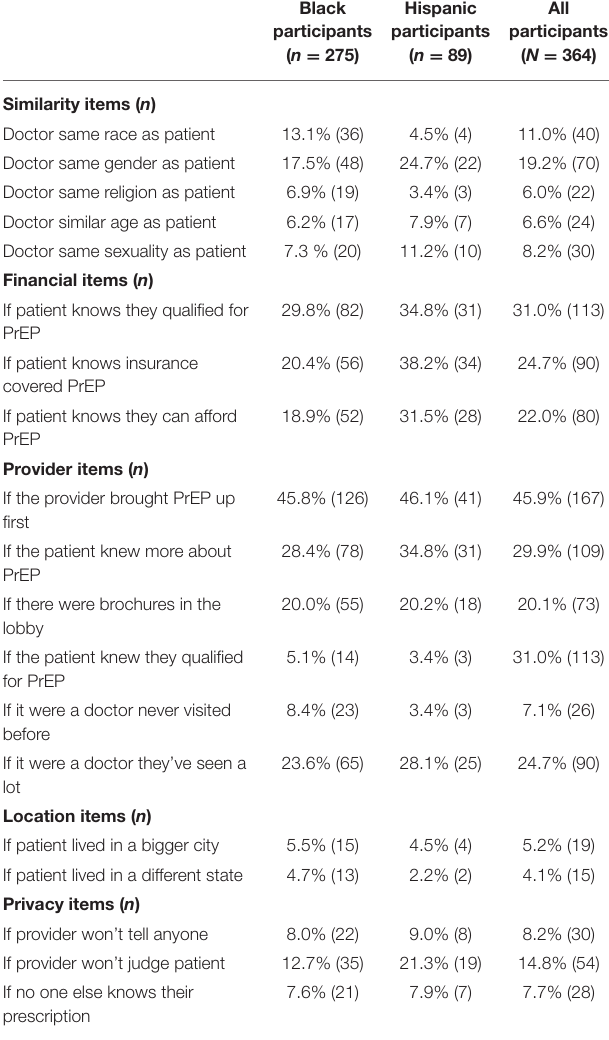
TABLE 4 | Frequency, interest, and usage of PrEP among black and hispanic participants.